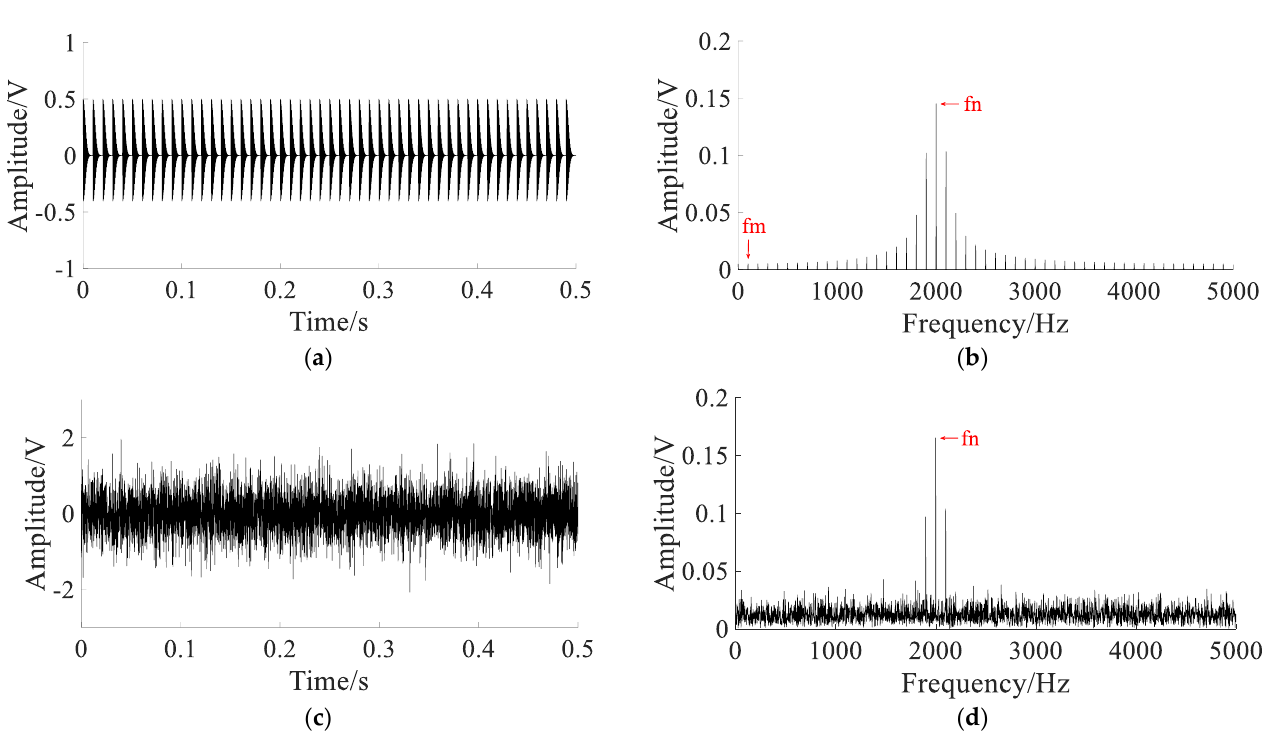
Figure 11. The simulated signals: ( a ) pure signal; ( b ) spectrum of pure signal; ( c ) noisy signal; ( d ) spectrum of noisy signal.